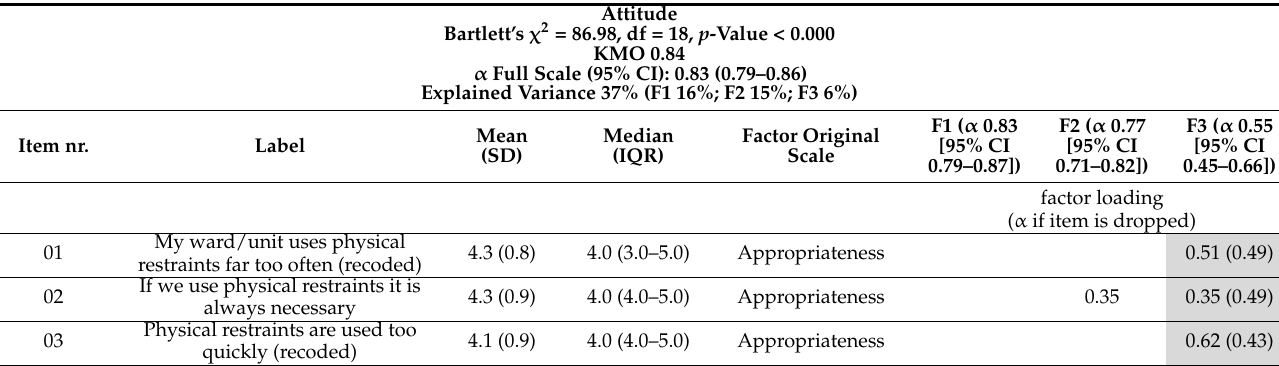
Table 3. Descriptive and factor analysis for the Attitude